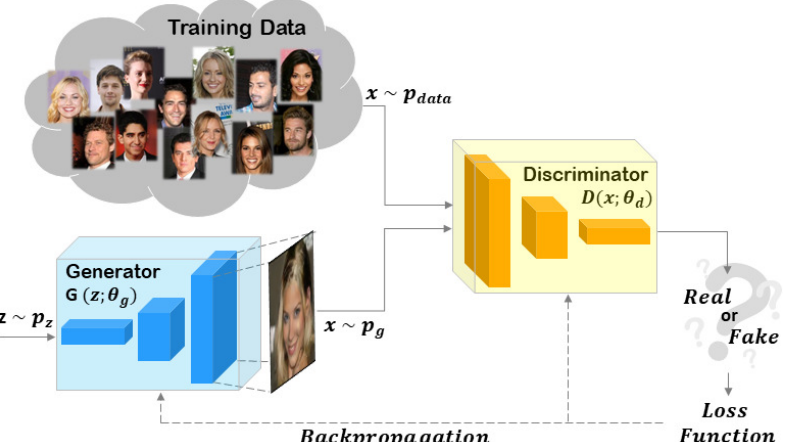
Figure 1. Generic scheme of a GAN architecture. The Generator and the Discriminator are the main components of the GAN. The objective of the Generator is to capture the data distribution of the training set. The goal of the Discriminator is to distinguish the images coming from the Generator compared to the training data. When the Generator creates images with the same data distribution of the training set, the Discriminator will no longer be able to solve its task and the training phase can be considered